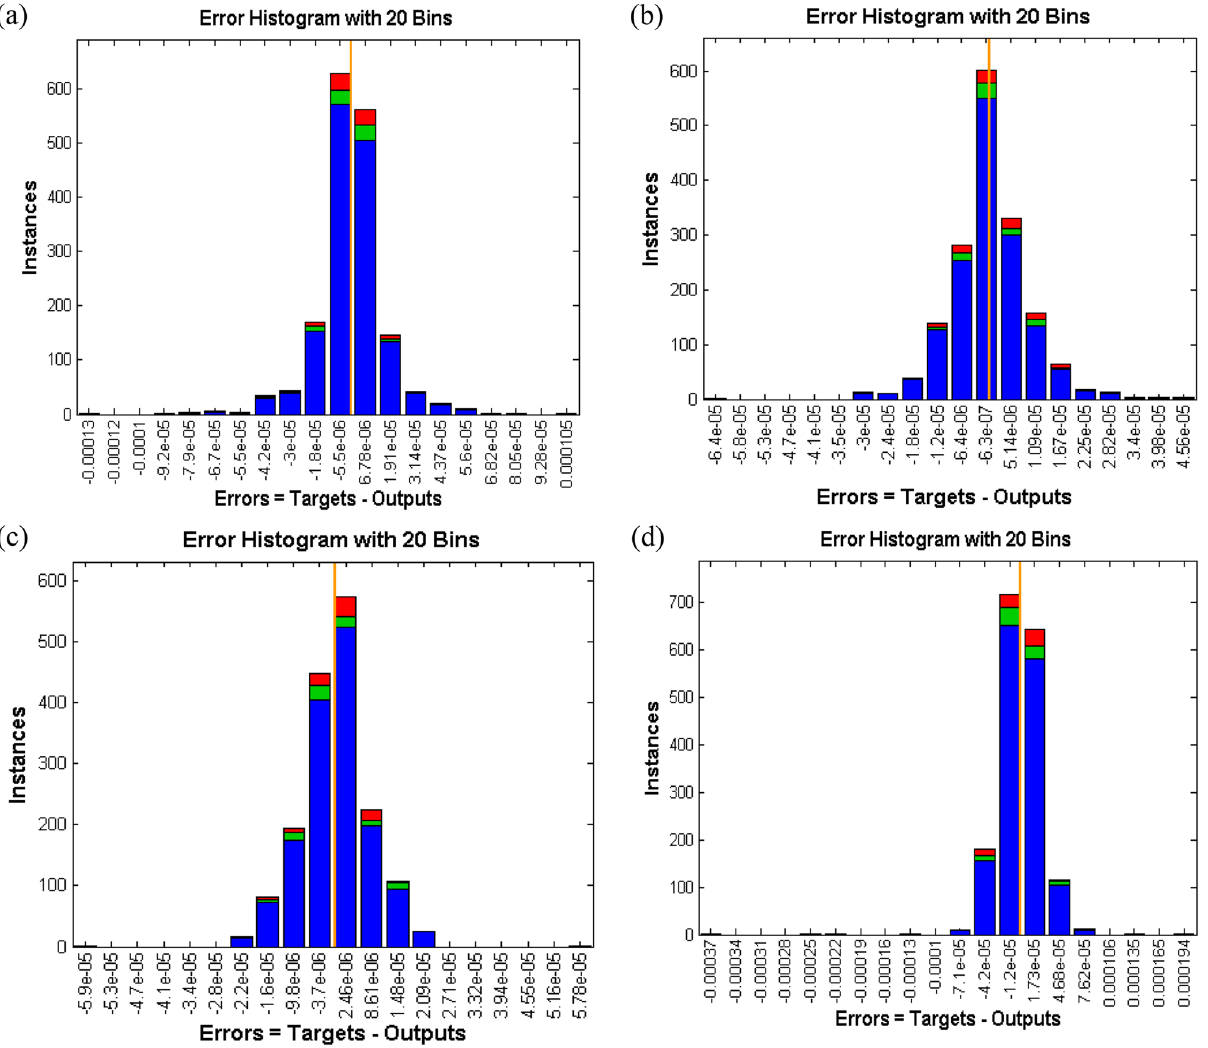
Figure 11. Error histogram of case study 1: scenario 1 ( a ) case 1, ( b ) case 2, ( c ) case 3 and ( d ) case